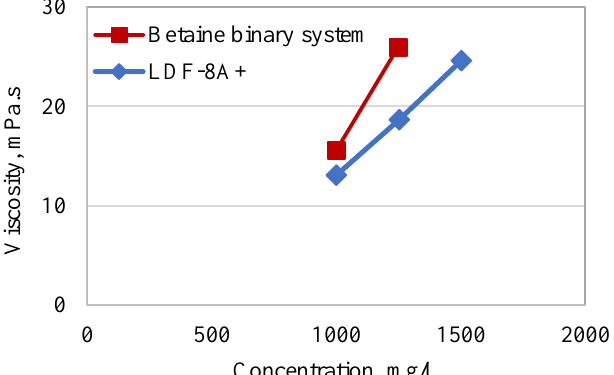
Figure 5—Viscosity and concentration curve of the binary